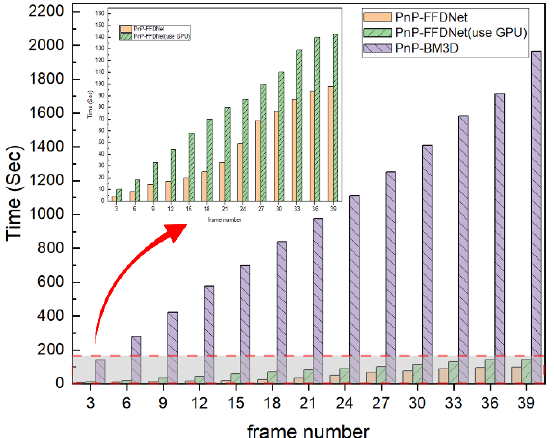
Figure 10. Line chart of SSIM of the reconstruction results of PnP-FFDNet and PnP-BM3D when the number of CUP compressed frames increases.